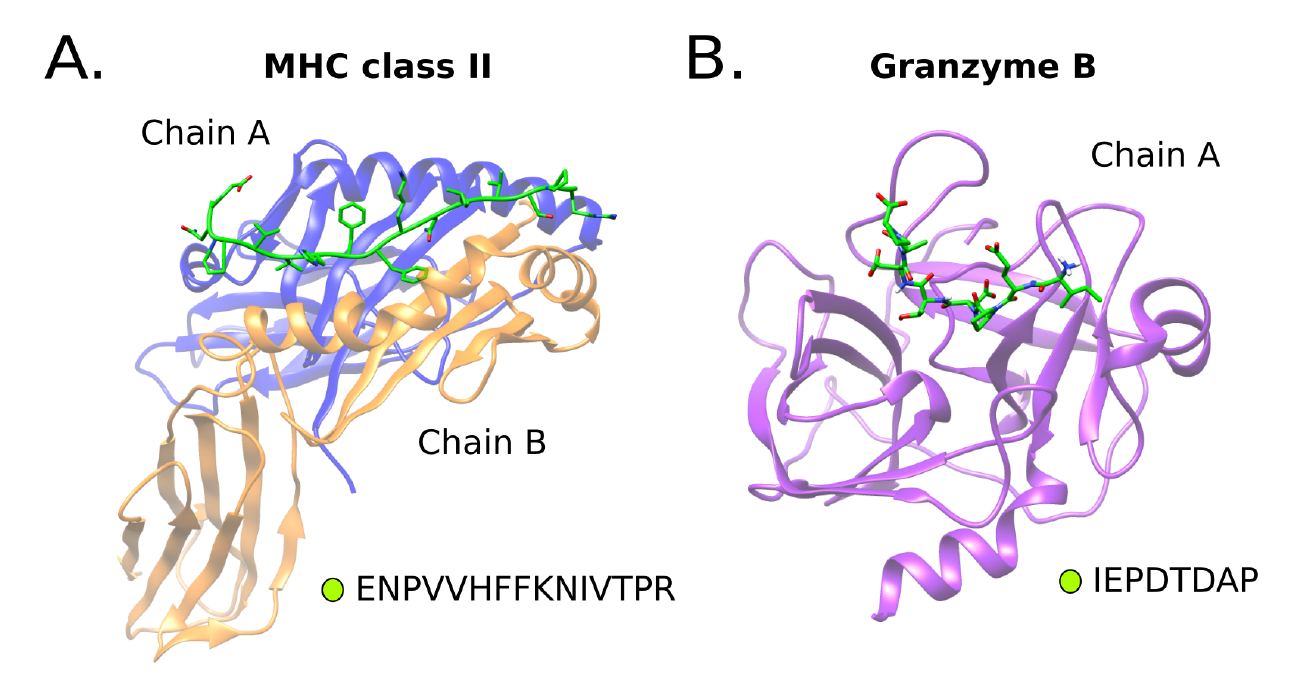
Figure 2. Protein peptide benchmark systems. Two systems were included in the analysis. An MHC class II allele structure (PDB id 1t5x) bound to a 15-mer peptide ( A ), and a Granzyme B protease protein (PDB id 1iau) bound to a 8-mer peptide substrate ( B